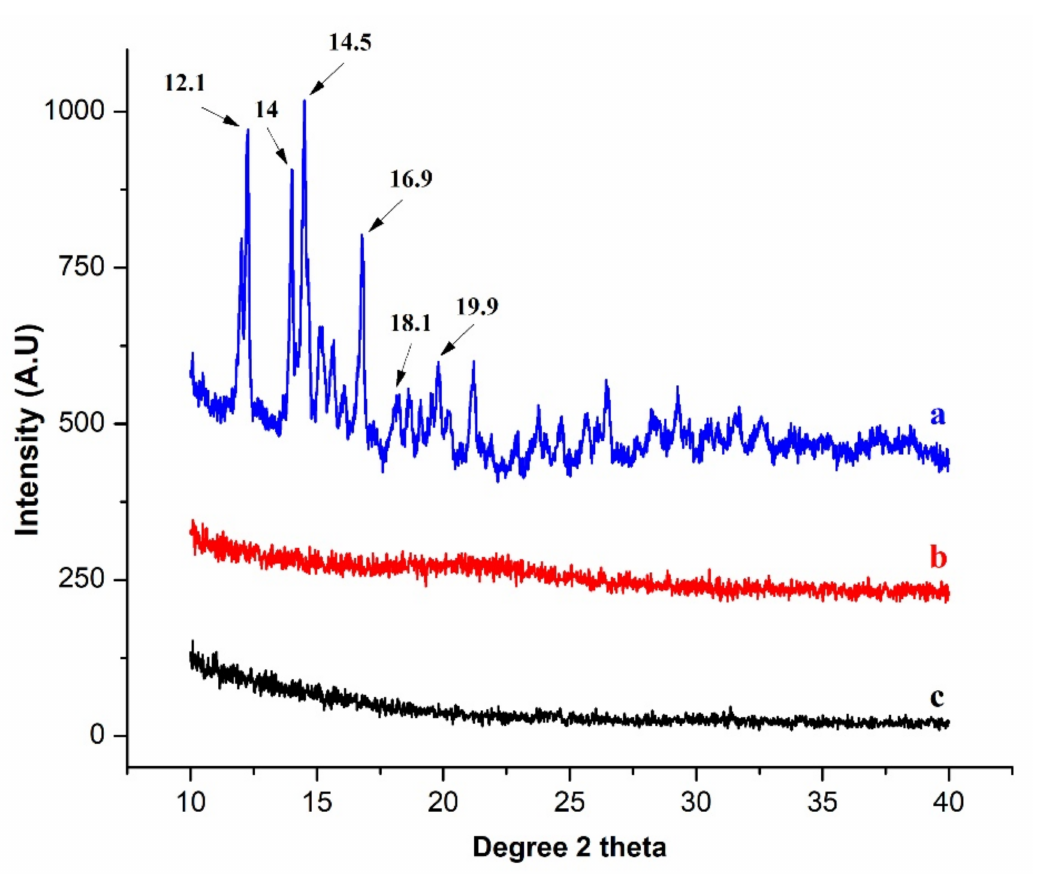
Figure 9. XRD histogram of: ( a ) DSP, ( b ) blank, and ( c ) drug-loaded AG-1 semi-IPN